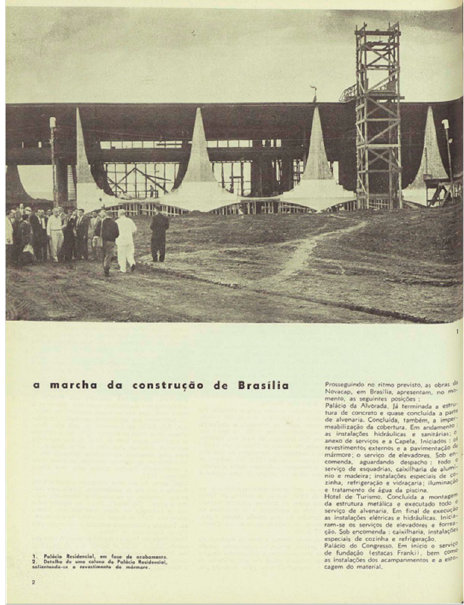
Figure 11. Column “A Marcha da Construção de Brasília, Revista Brasília , Ano 1, n. 10, 1957, courtesy of Arquivo Público do Distrito Federal.